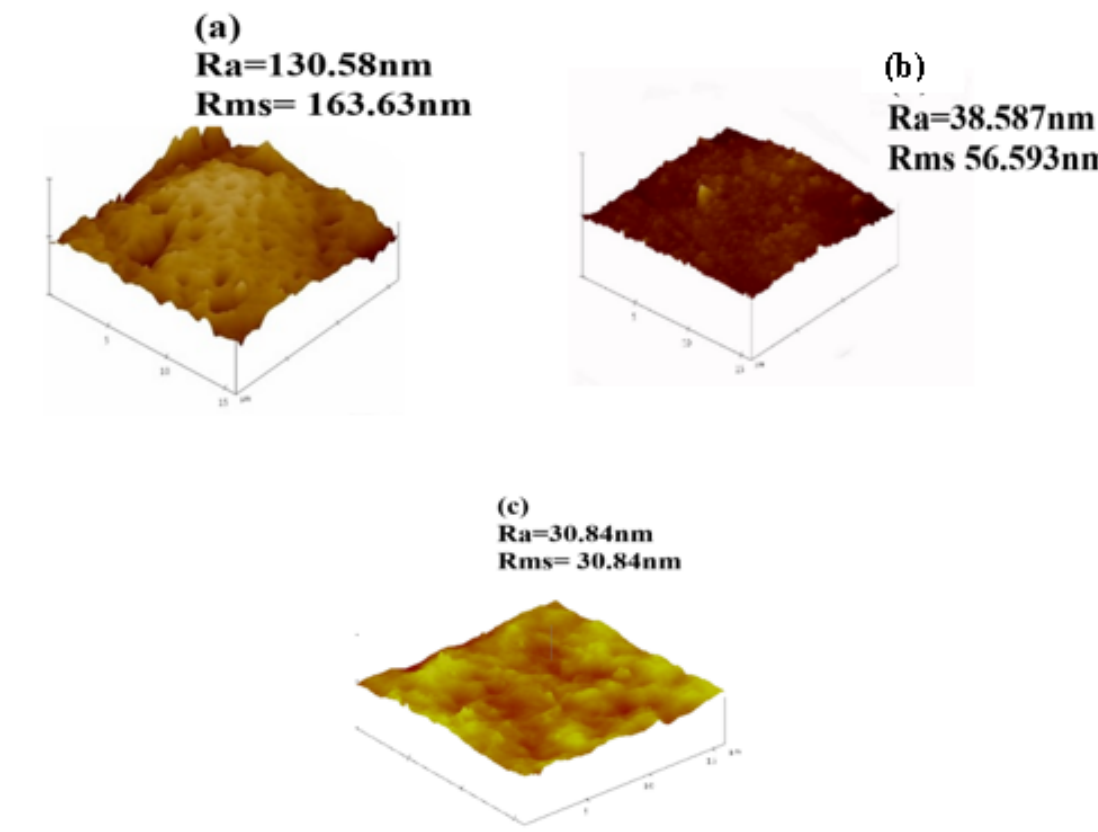
Figure 6. AFM images: ( a ) 0 wt.% NPs/PSF, ( b ) 10 wt.% HSOD/PSF, and ( c ) 10 wt.% SSOD/PSF.